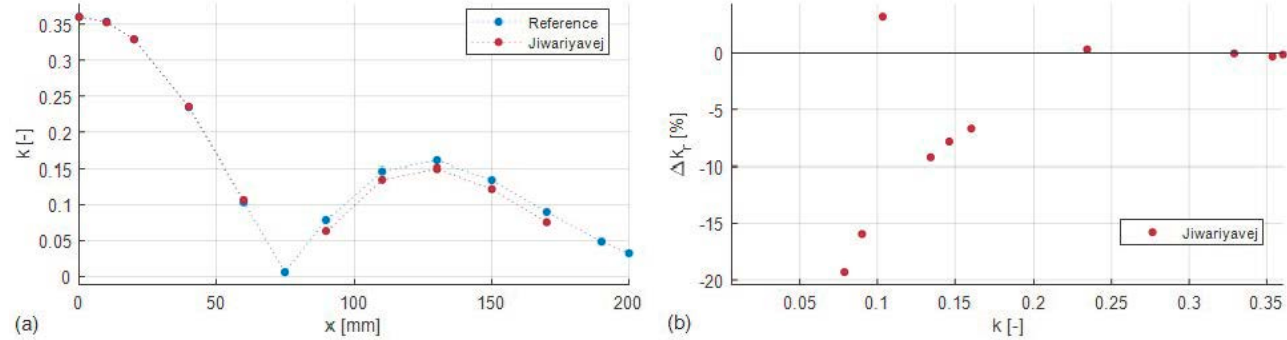
Figure 14. Method presented by Jiwariyavej in [18]. ( a ) Comparison with the reference measurement. ( b ) Relative error with respect to the reference over 𝑘 .